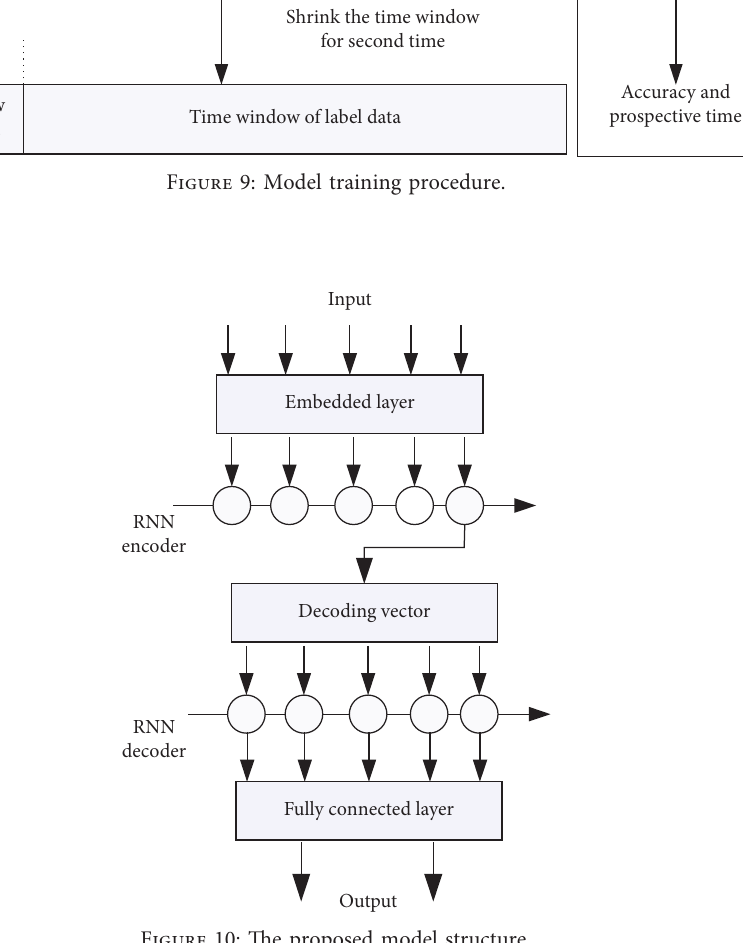
Figure 10: The proposed model structure.